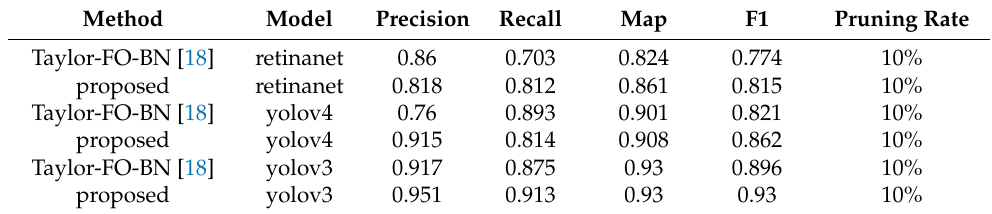
Table 3. The detection results were evaluated by the method in this paper and the comparison